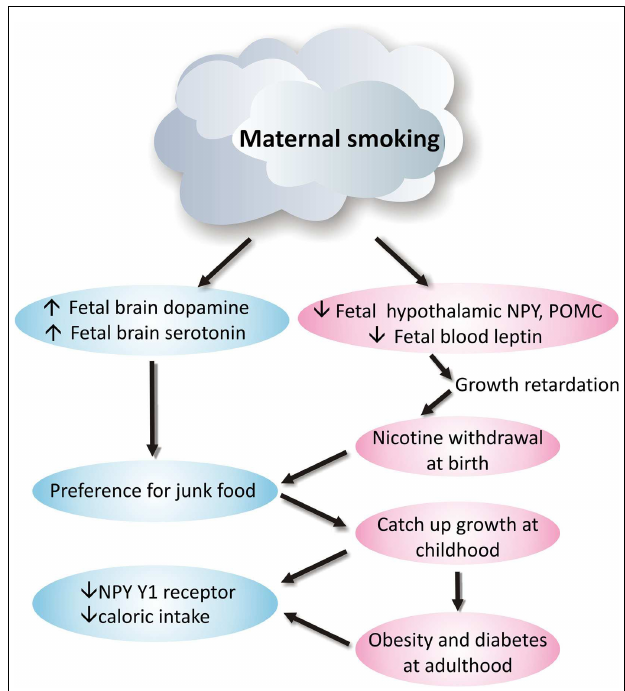
FIGURE 1 | Neurophysiological mechanism of how maternal smoking programs metabolic disorders in